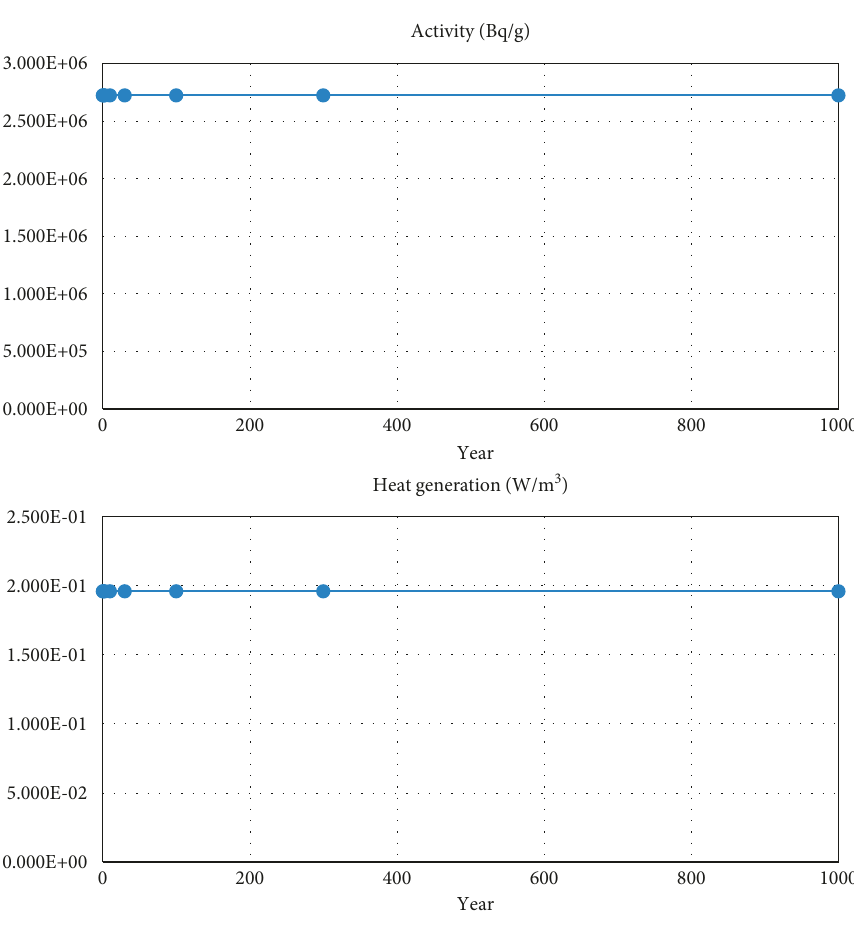
Figure 5: Radiological characteristics of I waste. Table 7: Radiological characteristics of iodoapatite waste